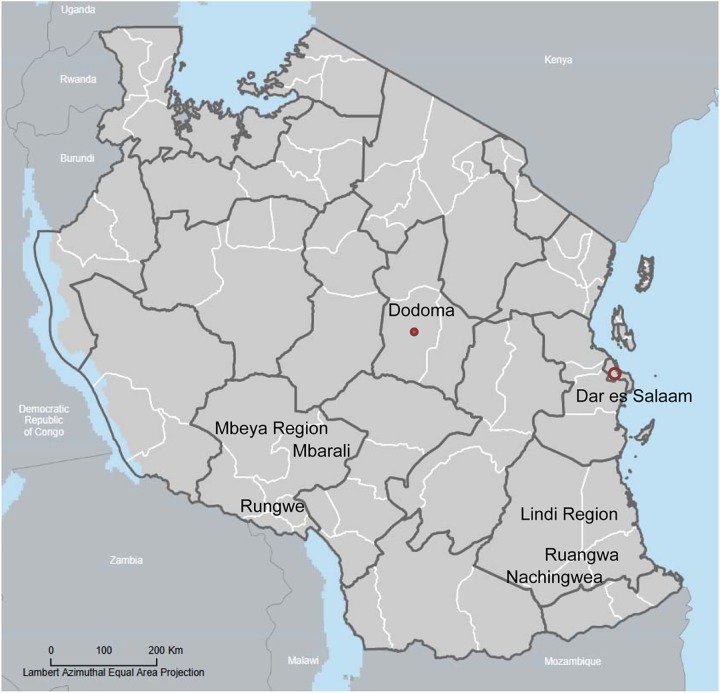
Map of mainland Tanzania showing the location of the four study districts.